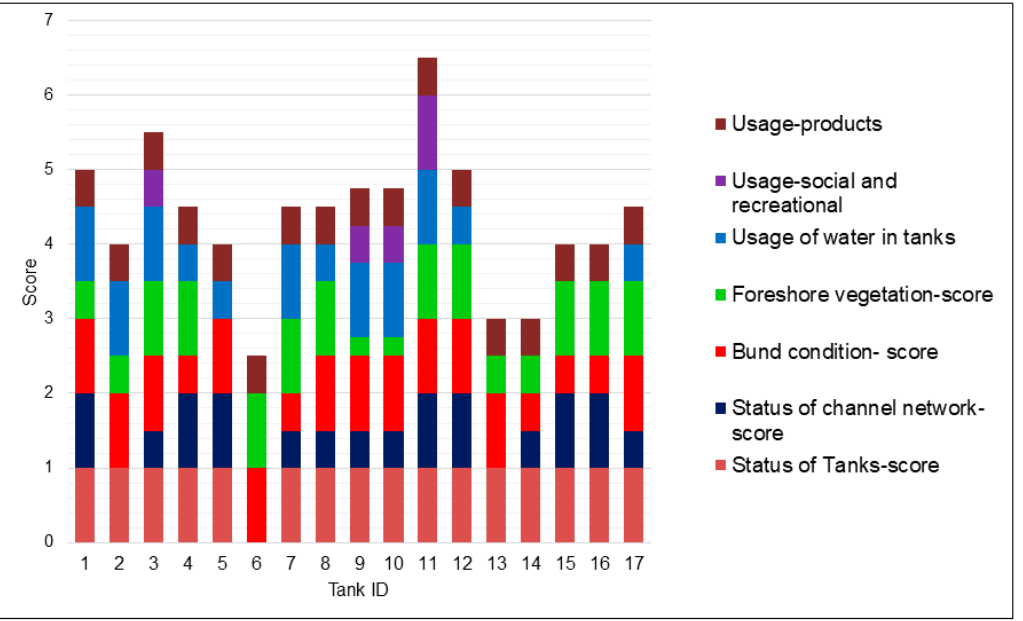
Figure 12. Case 2: Score of tanks based on components.